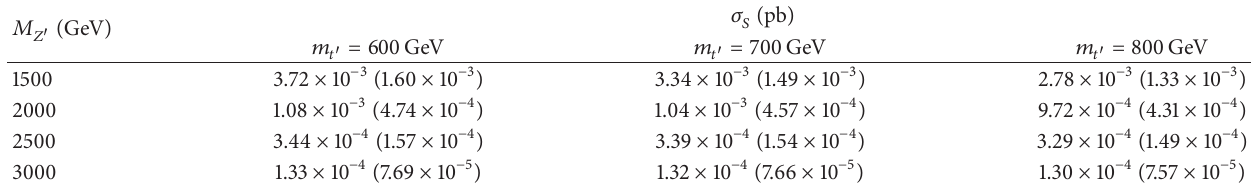
Table 10: The same as Table 7, but for 𝑥 = 0.5 .